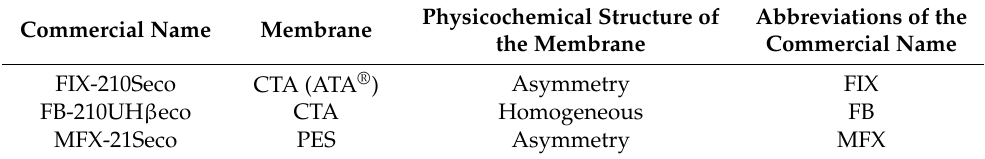
Table 1. Three investigated dialyzers.